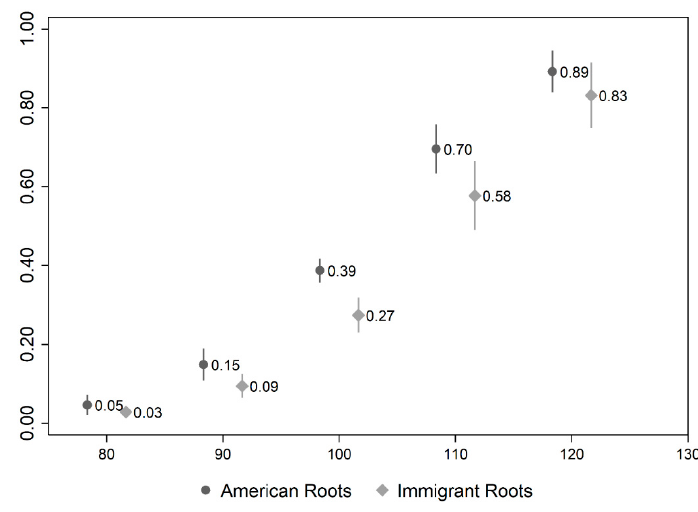
Figure 3. Probabilities of strongly agreeing with the deportation of law-breaking immigrants.